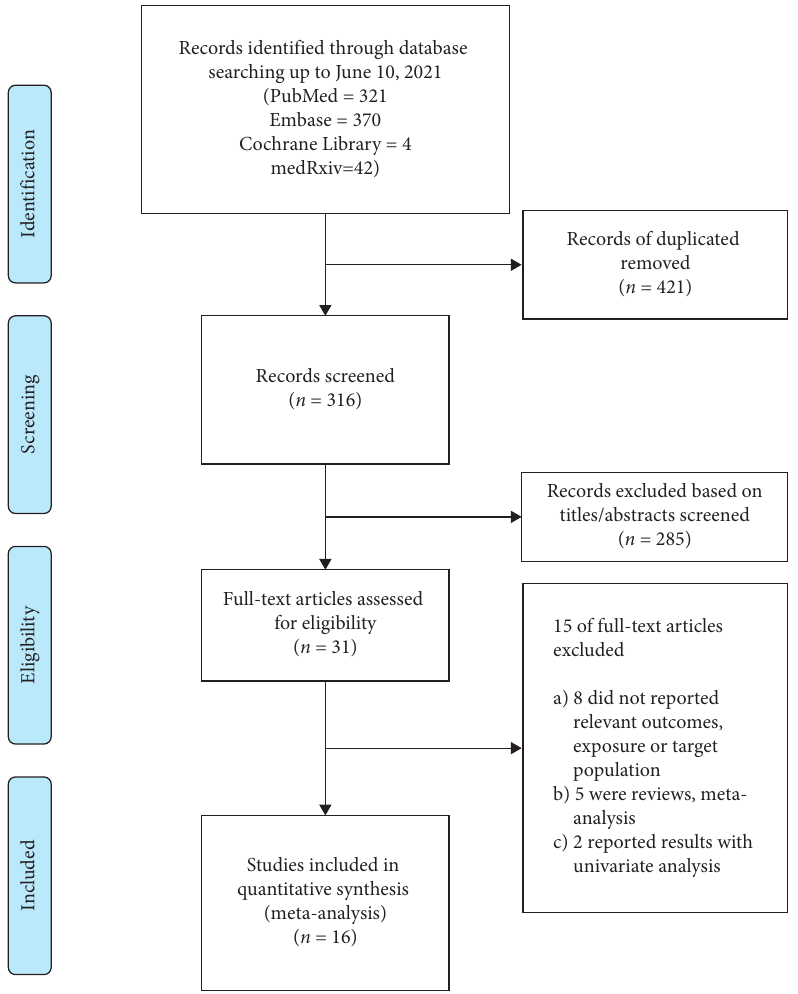
Figure 1: Flow chart of this